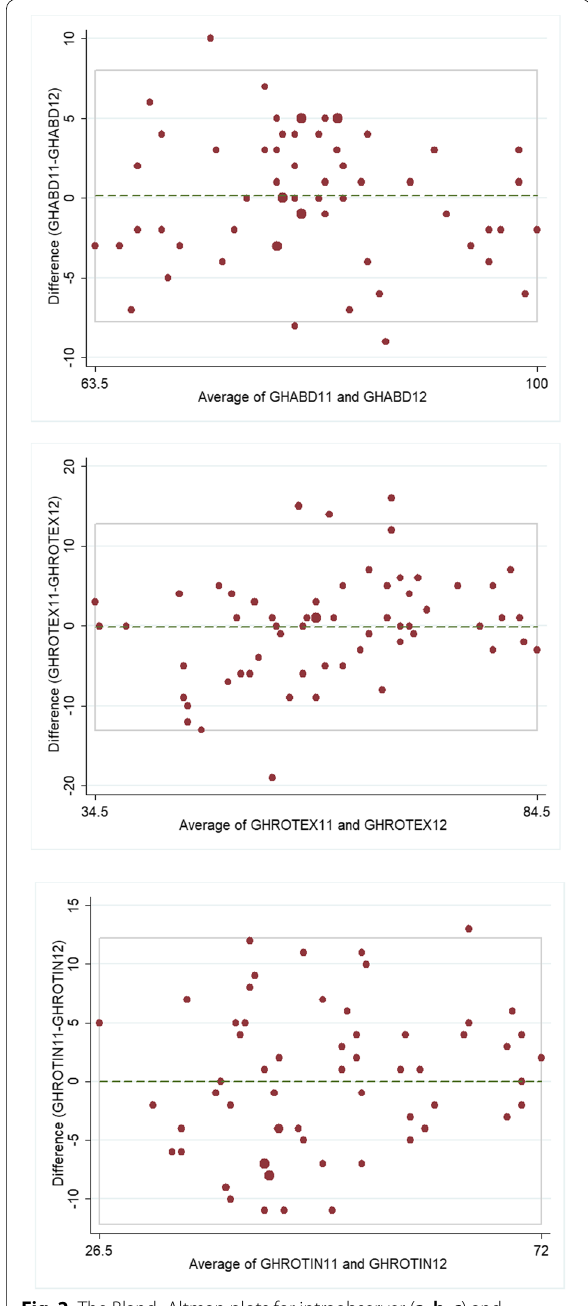
Fig. 2 The Bland–Altman plots for intraobserver ( a , b , c ) and interobserver ( d , e , f ) reproducibility for glenohumeral passive abduction (GH-PAS), external rotation (GH-PER) and internal rotation